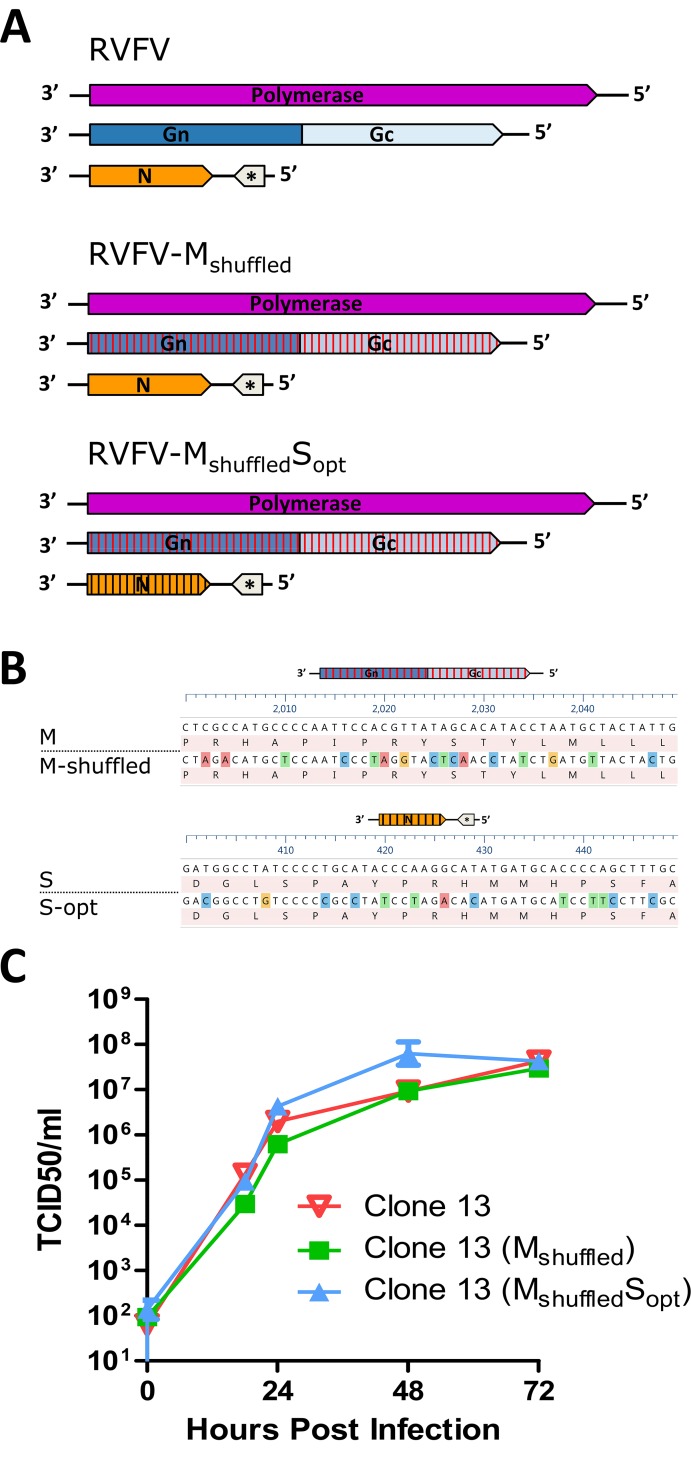
Growth of codon shuffled RVFV variants.(A) Schematic presentation of the viruses with shuffled or codon-optimized genes. (B) Part of the shuffled M segment and codon-optimized N gene sequence. (C) Growth curve of the indicated viruses in Vero cells infected at MOI 0.01. Supernatants were harvested at different time points and titrated on Vero cells.